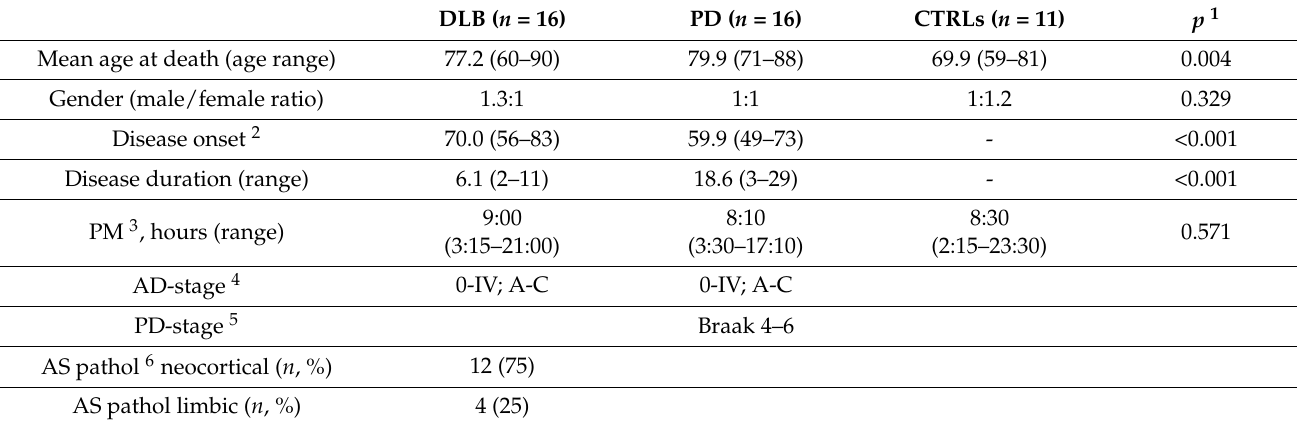
Table 1. Clinico-neuropathological characteristics of LBD patients and controls.